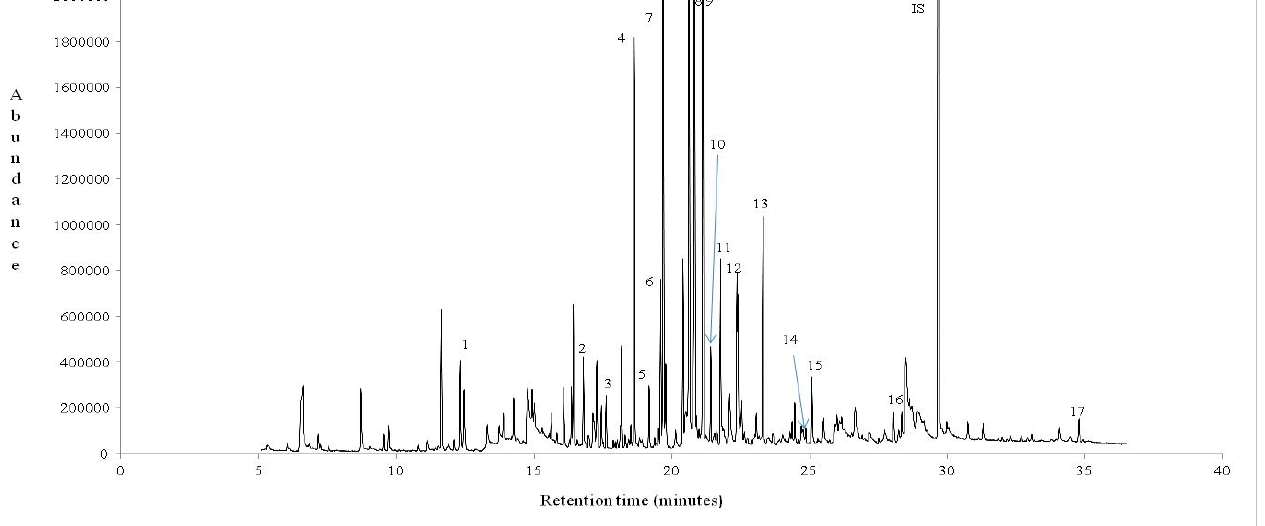
Figure 1. Gas chromatogram of citrus honey from Argos (Greece). Volatile compounds used as potential indicators of citrus honey geographical origin are numbered accordingly. 1: Octane. 2: Ben-